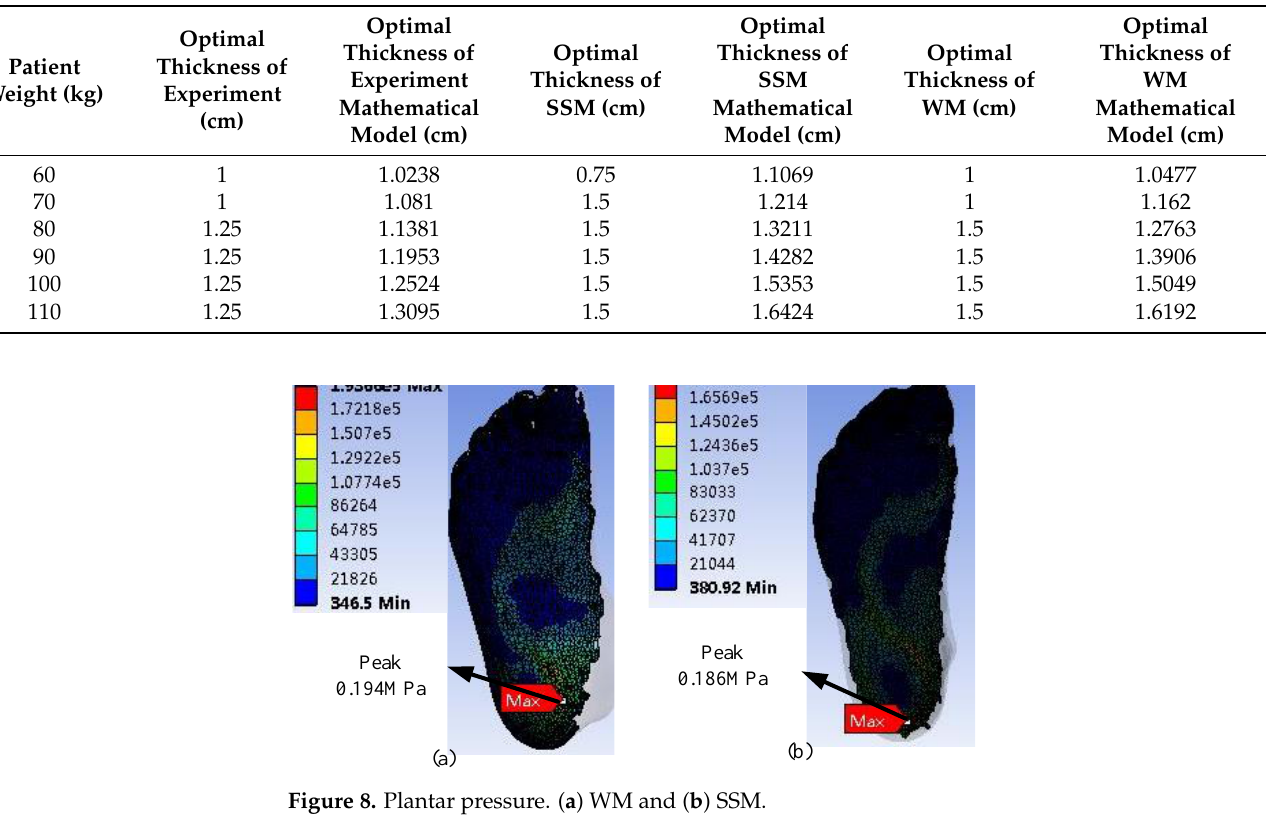
Table 3. Data on the relationship between different insole thicknesses and plantar pressures under human body weight in the WM.